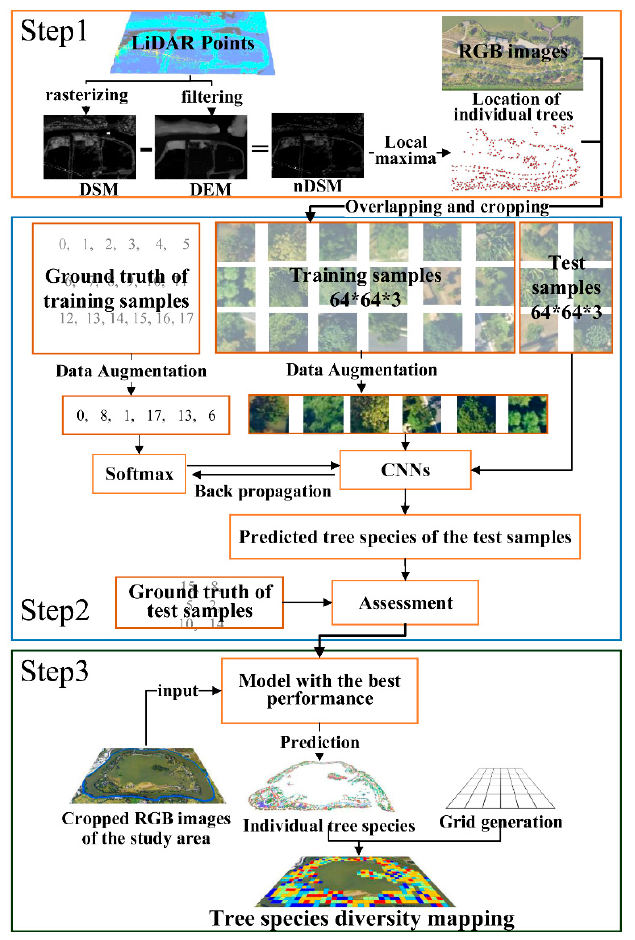
Figure 2. The flowchart that includes three main steps for identification of tree species based on the deep learning approaches.